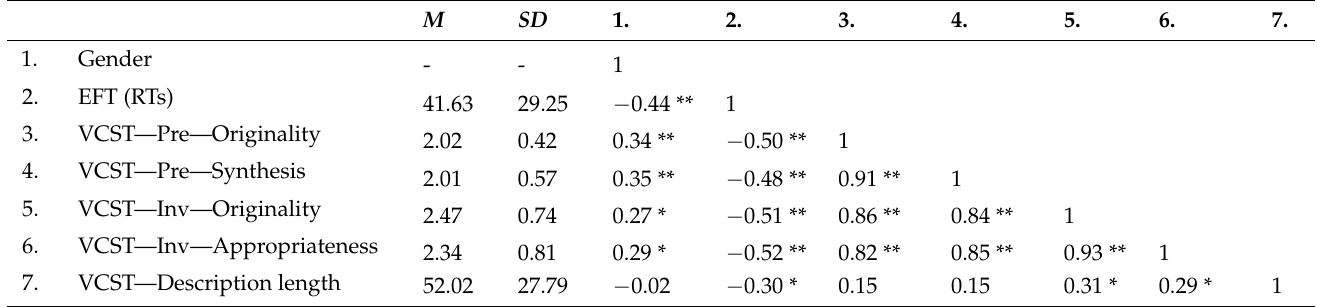
Table 2. Means, standard deviations, and Spearman’s Rho inter-correlations.